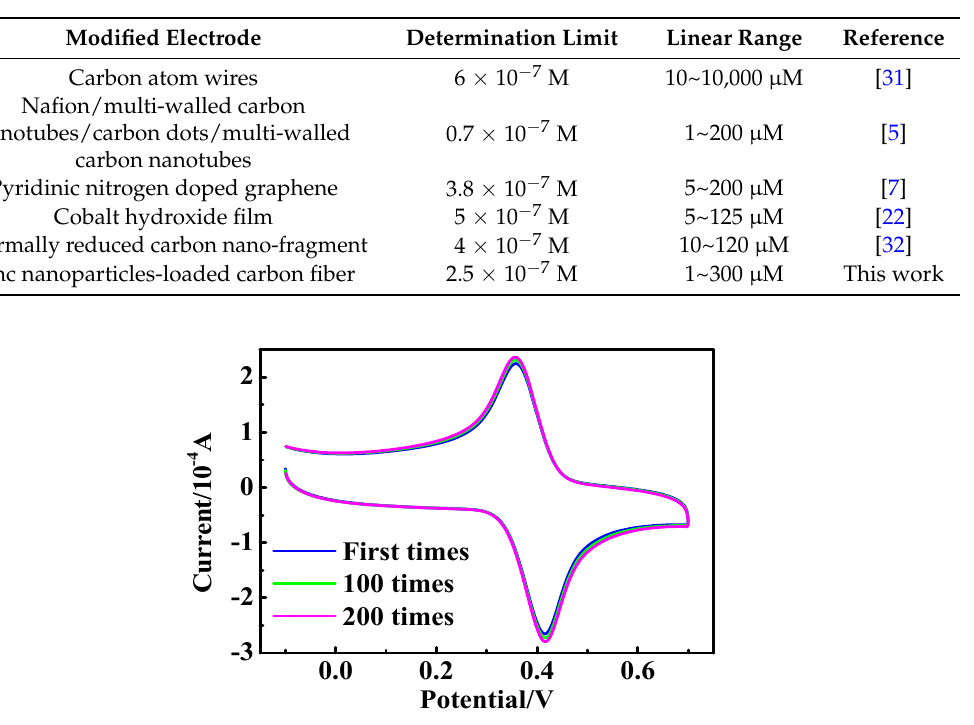
Figure 8. Circulation curves of ZCF/GCE in 0.1 M hydrochloric acid solution containing 1 mM HQ at a scan rate of 20 mV/s.